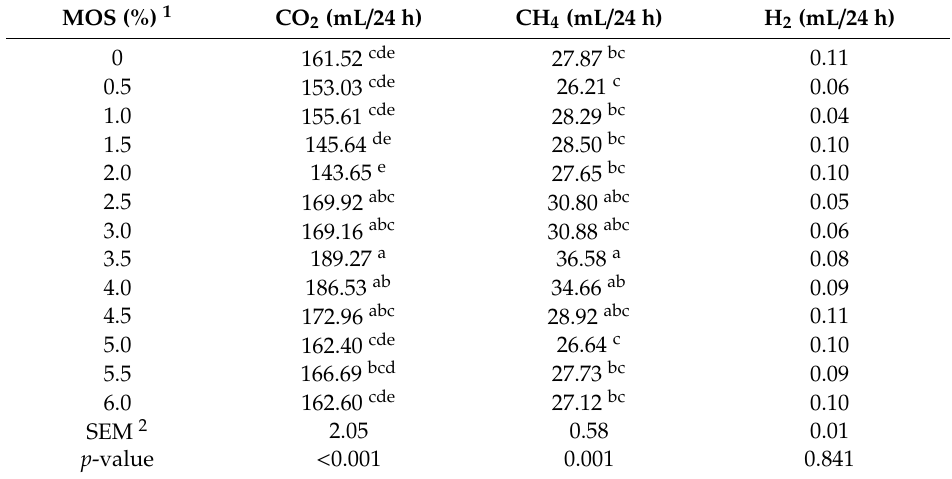
Table 2. In vitro CO 2 , CH 4 , and H 2 production with different amounts of adding mannan oligosaccharides (MOS). MOS (%) 1 CO 2 (mL / 24 h) CH 4 (mL / 24 h) H 2 (mL / 24 h) 0 161.52 cde 27.87 bc 0.11 0.5 153.03